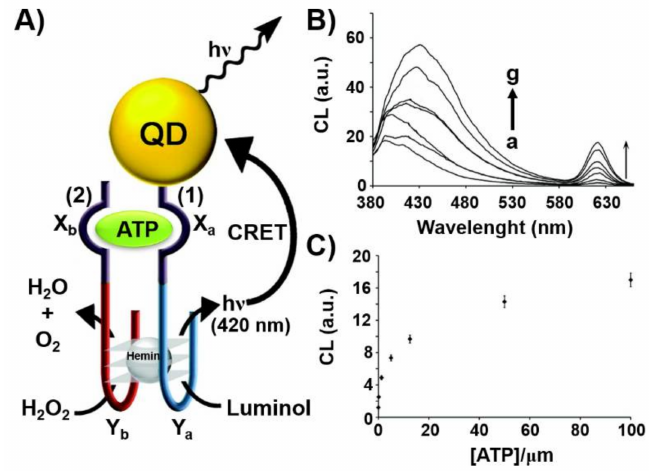
Figure 3. ( A ) Chemiluminescence resonance energy transfer (CRET)-induced sensing of ATP through the ATP-induced assembly of a supramolecular hemin/G-quadruplex-ATP aptamer/ATP complex on a semiconductor CdSe/ZnS quantum dot (QD). The hemin/G-quadruplex catalyzed oxidation of luminol in the presence of H 2 O 2 yields chemiluminescence that results in the CRET process to the QDs and in the luminescence of the QDs. ( B ) CRET-induced luminescence spectra of the QDs, λ em = 620 nm, in the presence of different concentrations of ATP: a = 0 µ M; b = 0.125 µ M; c = 1.25 µ M; d = 5 µ M; e = 12.5 µ M; f = 50 µ M; g = 100 µ M. ( C ) Derived calibration curve for the CRET-induced analysis of ATP by the nucleic acid/QD hybrid. Reproduced with permission from ref. [92]. Copyright 2011 American Chemical Society. Arrows: the arrows correspond to typical excitation